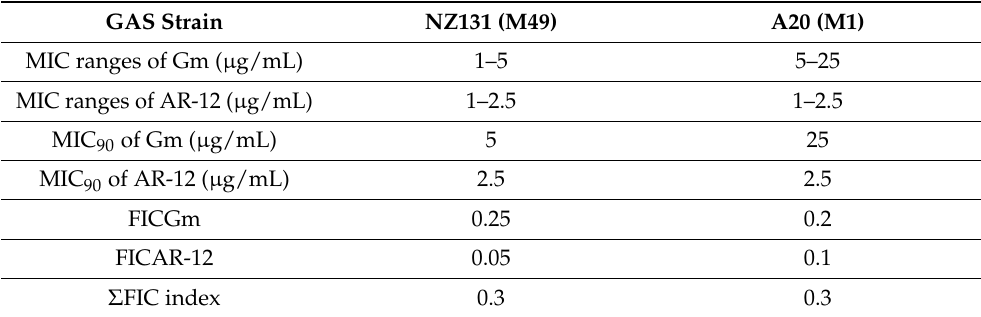
Table 1. AR-12 enhanced the in vitro antibacterial activity of gentamicin against group A Streptococcus .